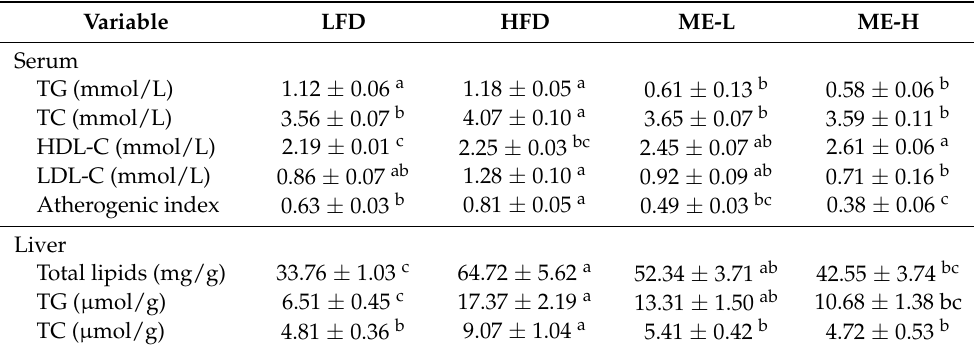
Table 2. Lipid profiles in serum and